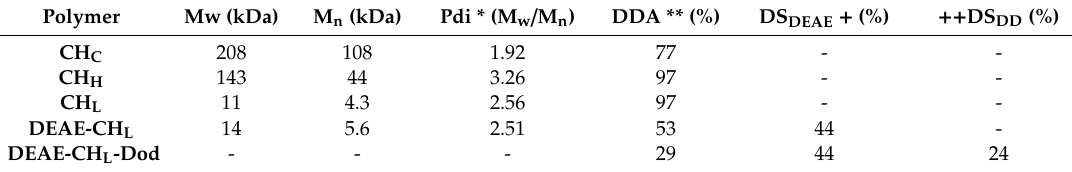
Table 1. Properties of chitosan and its amphiphilic derivatives.